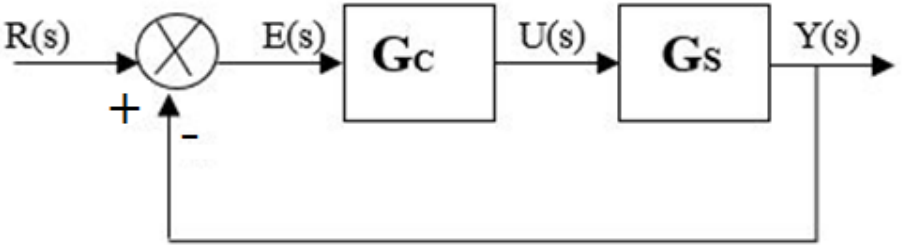
Figure 1. Block diagram of PID controllers [2].